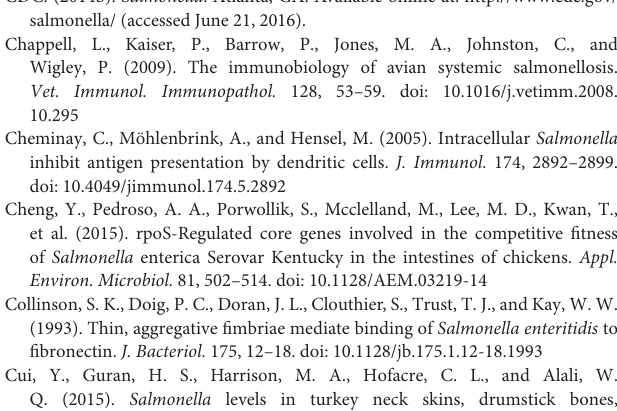
Chickens and turkeys can shed Salmonella